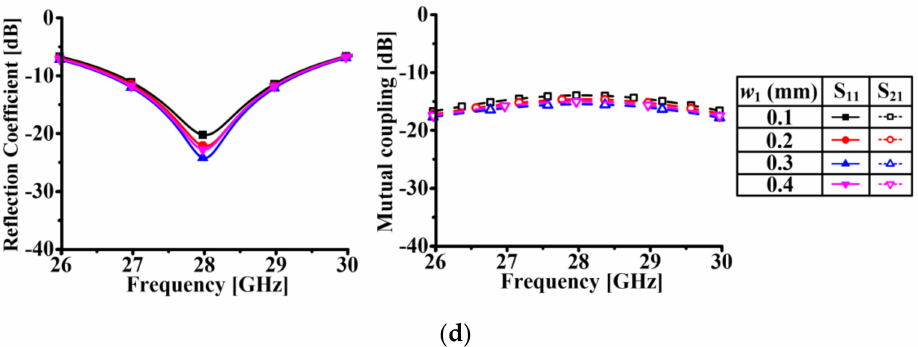
Figure 4. Parameter studies of the dimension of Slit 1: ( a ) antenna structure with Slit 1, ( b ) simulated surface current distribution at 28 GHz (when h 1 = 2.4 mm and w 1 = 0.3 mm), ( c ) simulated results of the reflection coe ffi cient and mutual coupling with various lengths ( h 1 ) of Slit 1 ( w 1 is fixed at 0.3 mm), and ( d ) simulated results of the reflection coe ffi cient and mutual coupling with various widths ( w 1 ) of Slit 1 ( h 1 is fixed at 2.4 mm).